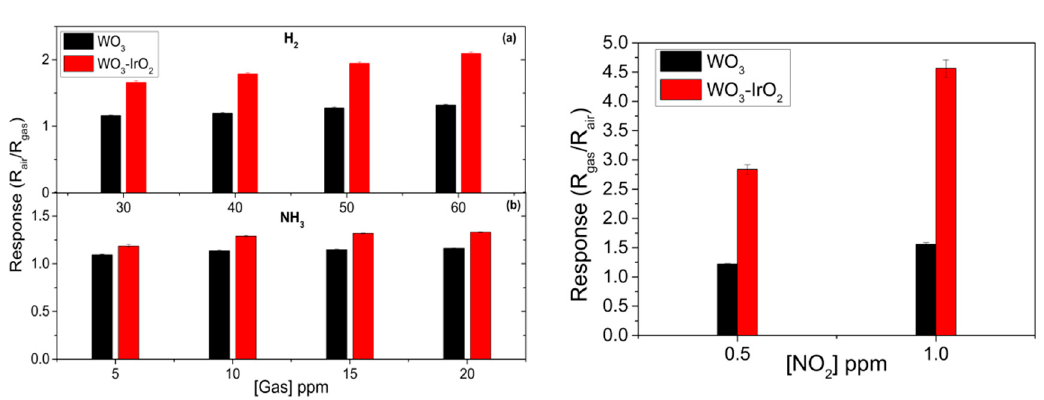
Figure 3. Left panel: ( a ) H 2 and ( b ) NH 3 response. Right panel: response towards oxidizing